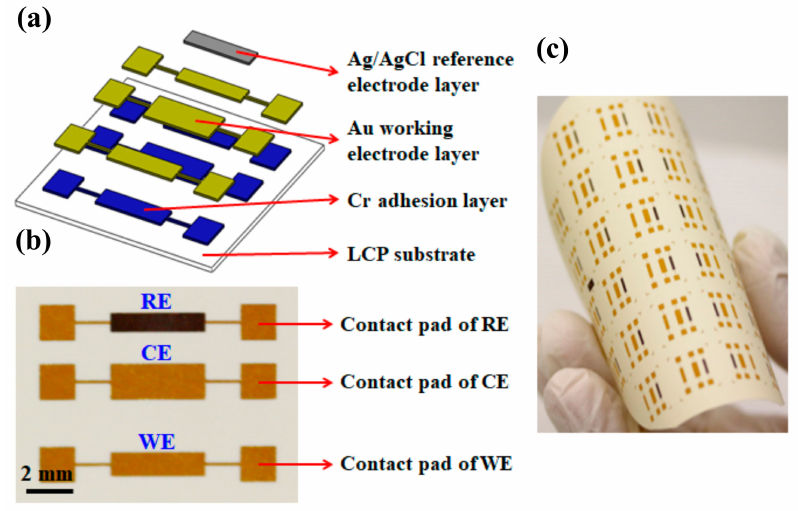
Figure 1. ( a ) Schematic drawing to illustrate the structure of the chemical sensor. ( b ) Photograph of one sensor after fabrication, where ‘RE’, reference electrode; ‘CE’, counter electrode; ‘WE’, working electrode. ( c ) Photograph to show a fabricated sensor array after